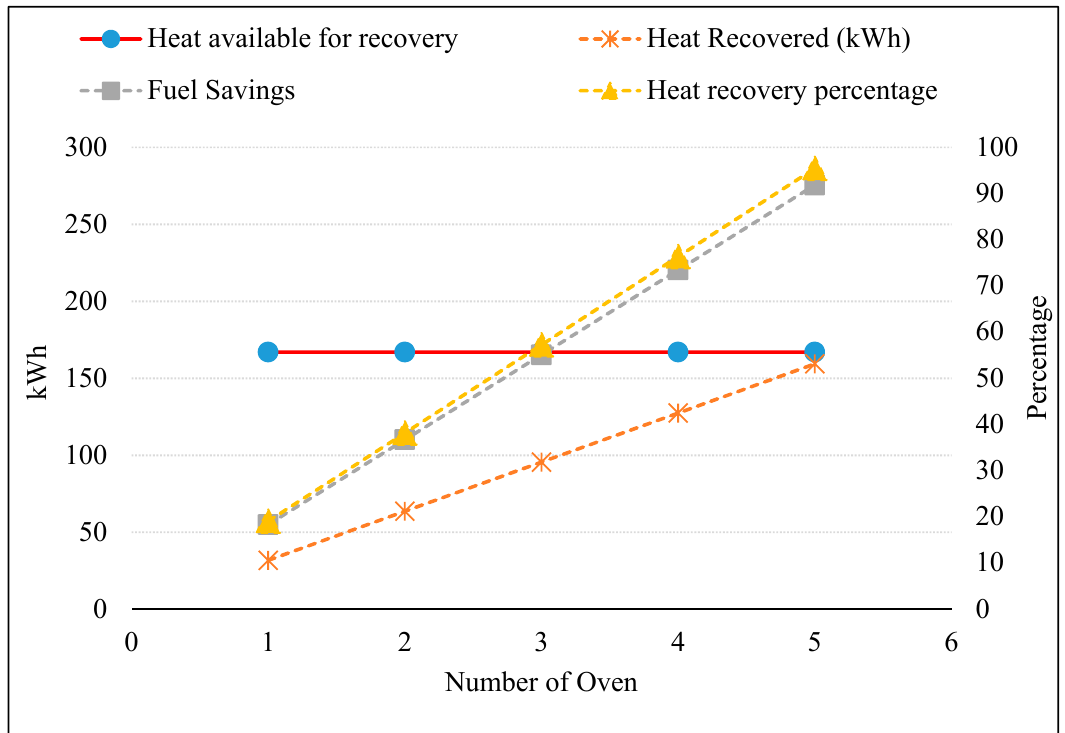
Figure 10. Savings obtained by preheating combustion air of multiple ovens. Table 10. Key performance indicators of the industrial-scale baking oven before and after heat recovery to preheat combustion air of five ovens.